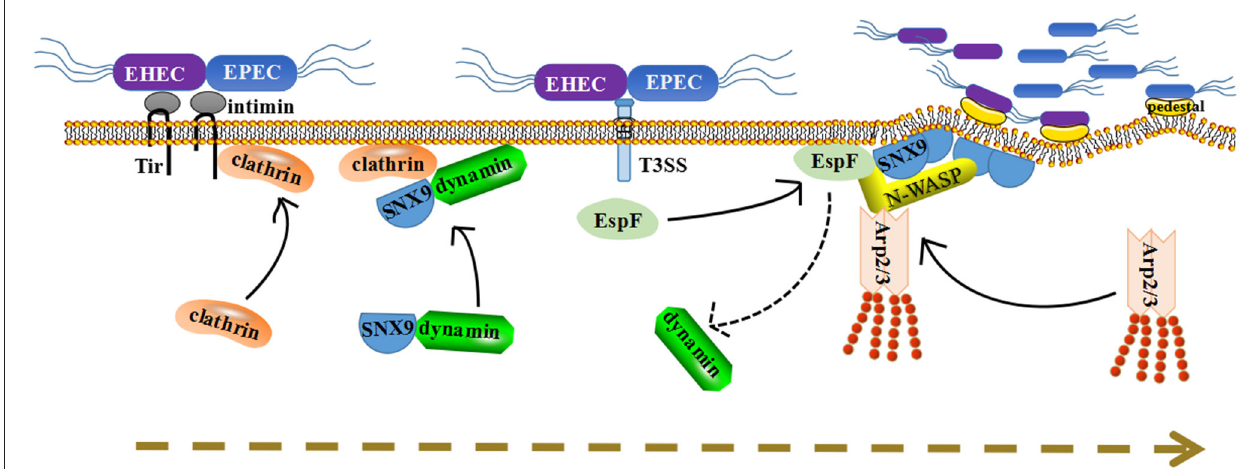
FIGURE 2 | A dynamic model for how EspF protein potentially promotes the colonization of bacteria in host cells through protein interactions. First, Tir inserts into the plasma membrane and recruits clathrin to accumulate at the point of pathogen attachment. Second, under normal circumstances, SNX9 will recruit its partner dynamin to membrane areas. Once EspF comes, it binds to SNX9 protein in competition with dynamin, and their solid interaction induces SNX9 oligomerization and increases membrane deformation activity. Third, SNX9 interacts with N-WASP, as well as with EspF, to form a complex and trigger Arp2/3-dependent polymerization of branched-chain actin filaments. Thus, we propose that their interaction facilitates the colonization of pathogenic bacteria step-by-step: membrane deformation, actin polymerization, pedestal formation, and colonization